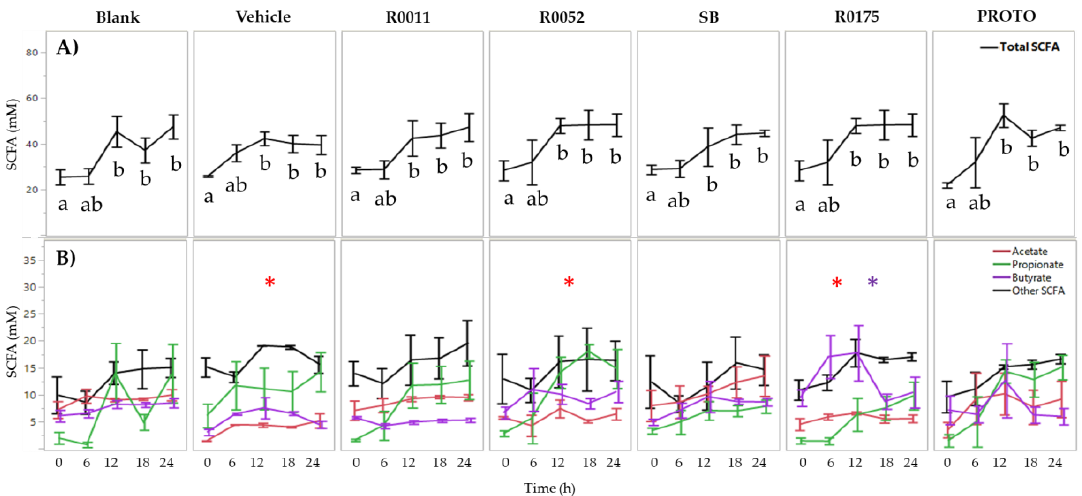
Figure 1. Short-chain fatty acid (SCFA) analysis of normal FW. ( A ) Total SCFA quantification and ( B ) individual SCFA quantification. Values are presented as the means ± SEM. Means at time points within treatments without a common letter are significantly different ( p < 0.05). The symbol * in red represents significant differences in acetate production between treatment and blank ( p < 0.05) when the means of all time points are jointly considered. The symbol * in purple represents significant differences in butyrate production between treatment and blank ( p < 0.05) when the means of all time points are jointly considered. R0011 = L. rhamnosus R0011; R0052 = L. helveticus R0052; SB = S. boulardii CNCM I-1079; R0175 = B. longum R0175; PROTO = ProtecFlor TM .